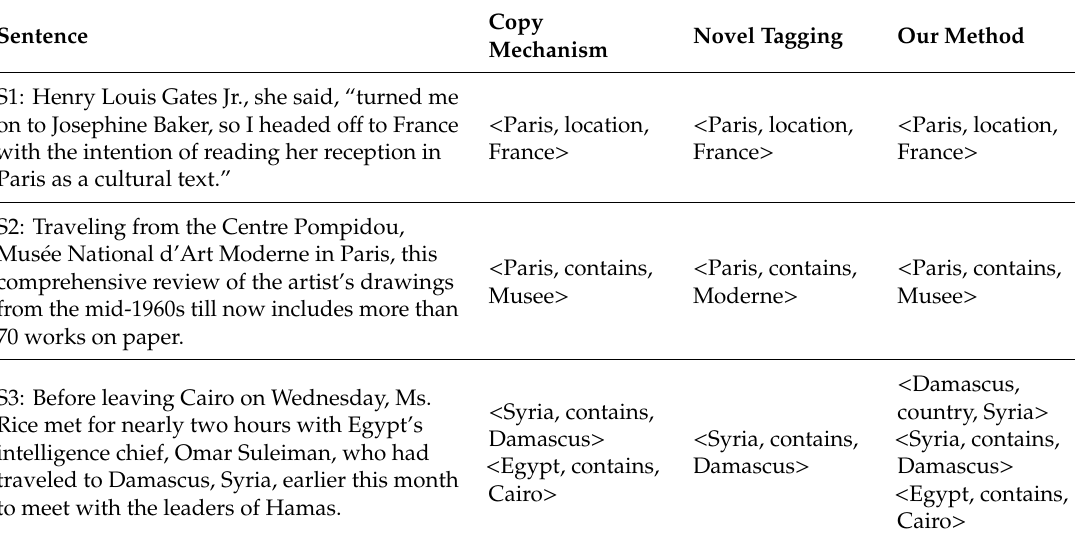
Table 2. Representative results from di ff erent models. S1 is a normal class; both models extracted it correctly. S2 is a negative example. S3 represents a case in which entity pairs are